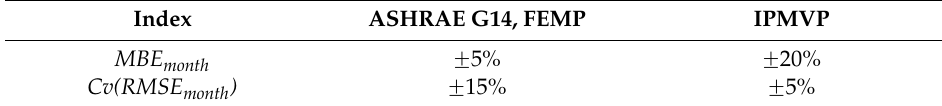
Table 5. Acceptable tolerance for the calibrated simulation using monthly measured data.